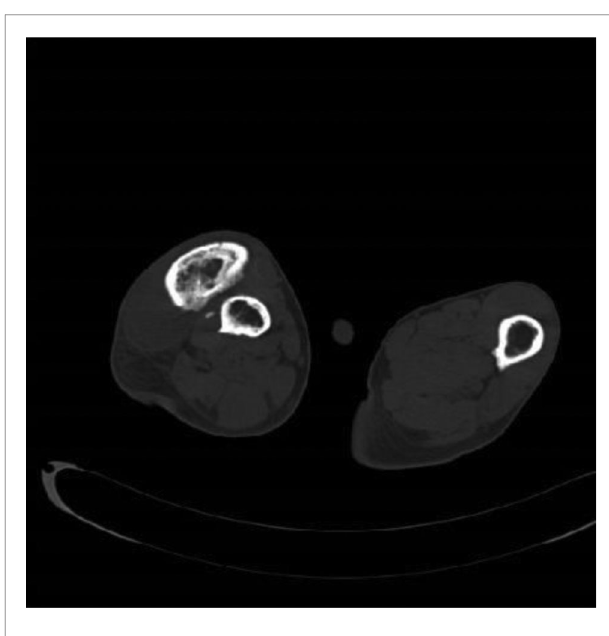
FIGURE 3 | Preoperative CT.